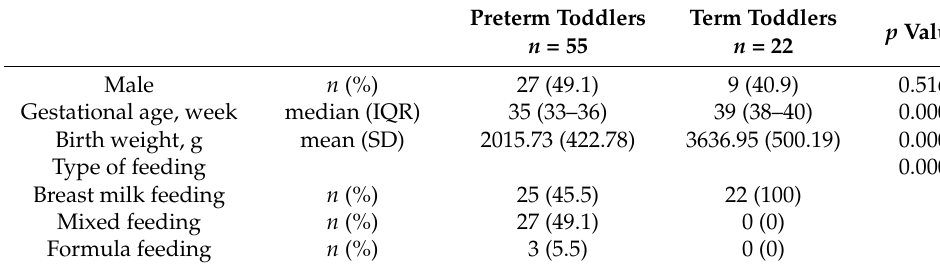
Table 1. Clinical characteristics of preterm toddlers and term toddlers enrolled.